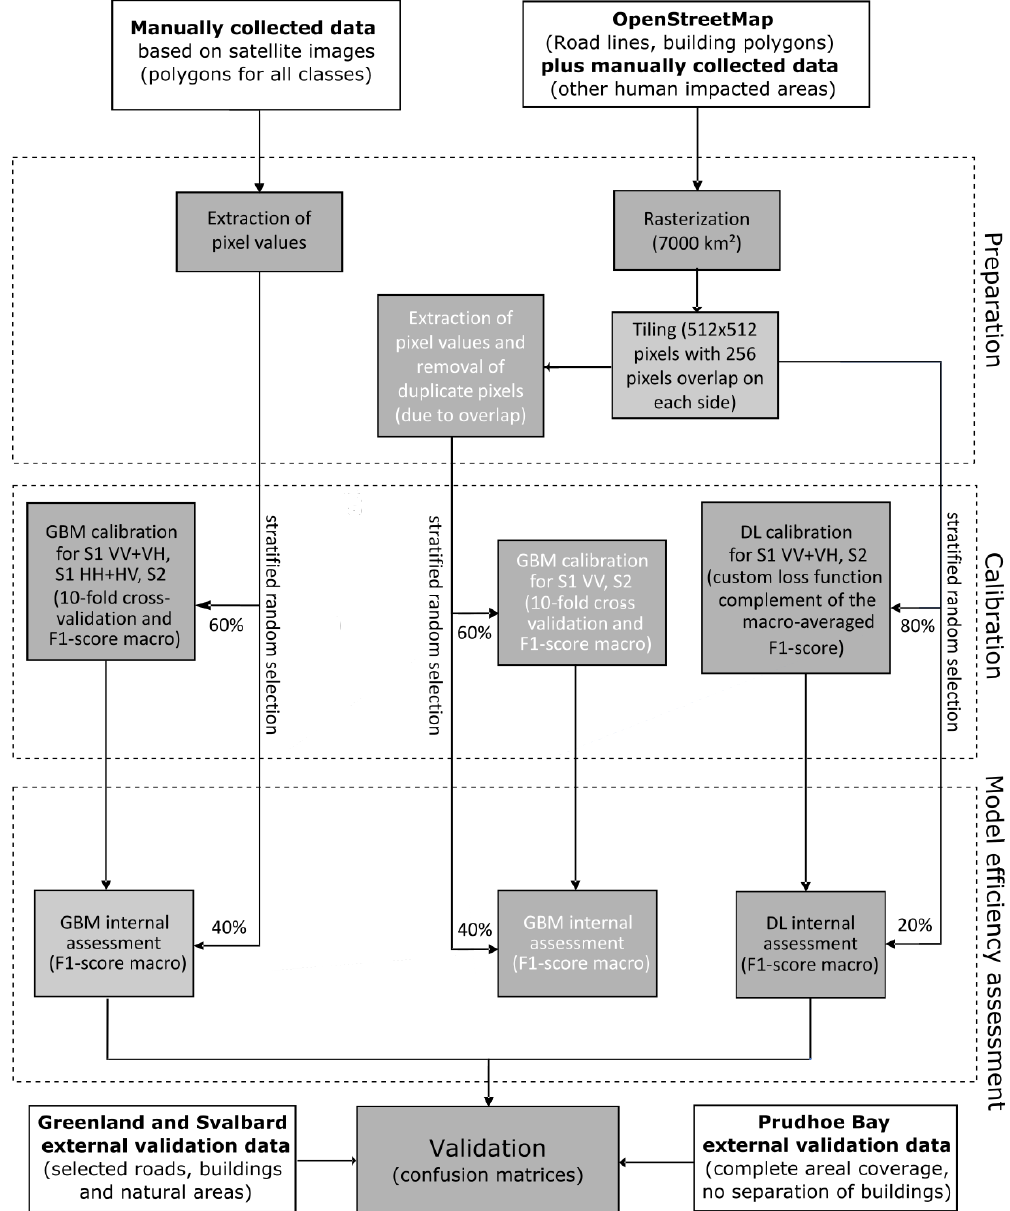
Figure 4. Workflow of the calibration, internal assessment and validation. DL—deep learning, GBM—gradient boosting machines, S1—Sentinel-1,